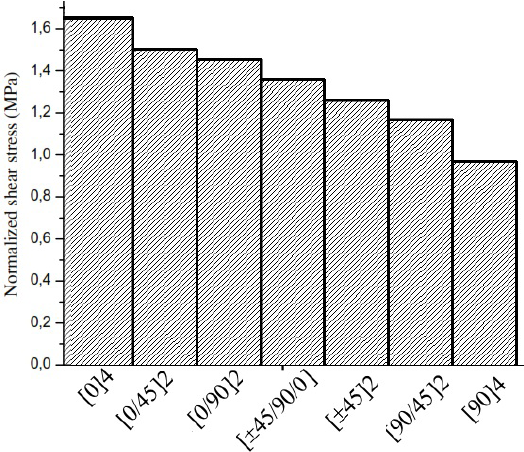
Figure 16. Influence of the patch stacking sequence on the shear stress τ * for a plate [45/90] 2s.